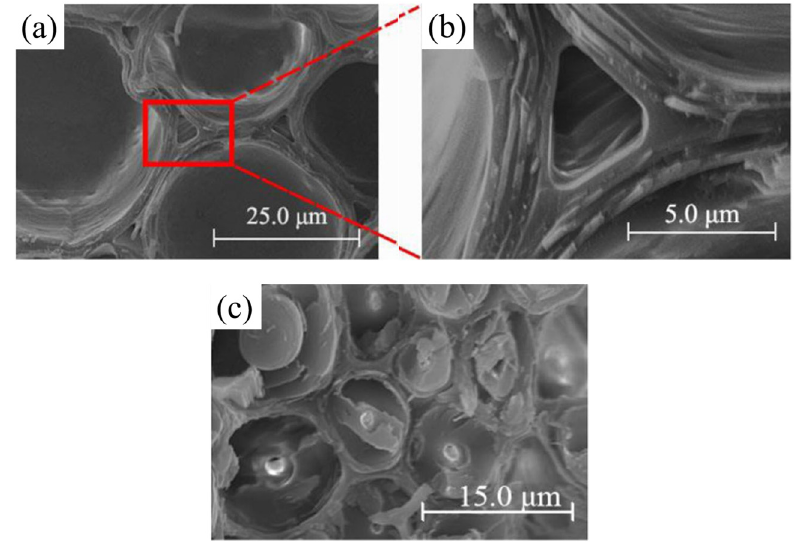
Figure 2: SEM images of bamboo cell wall structures: ( a and b ) untreated parenchyma cells [ 4 ] and ( c ) untreated sclerenchyma cells [ 4 ]